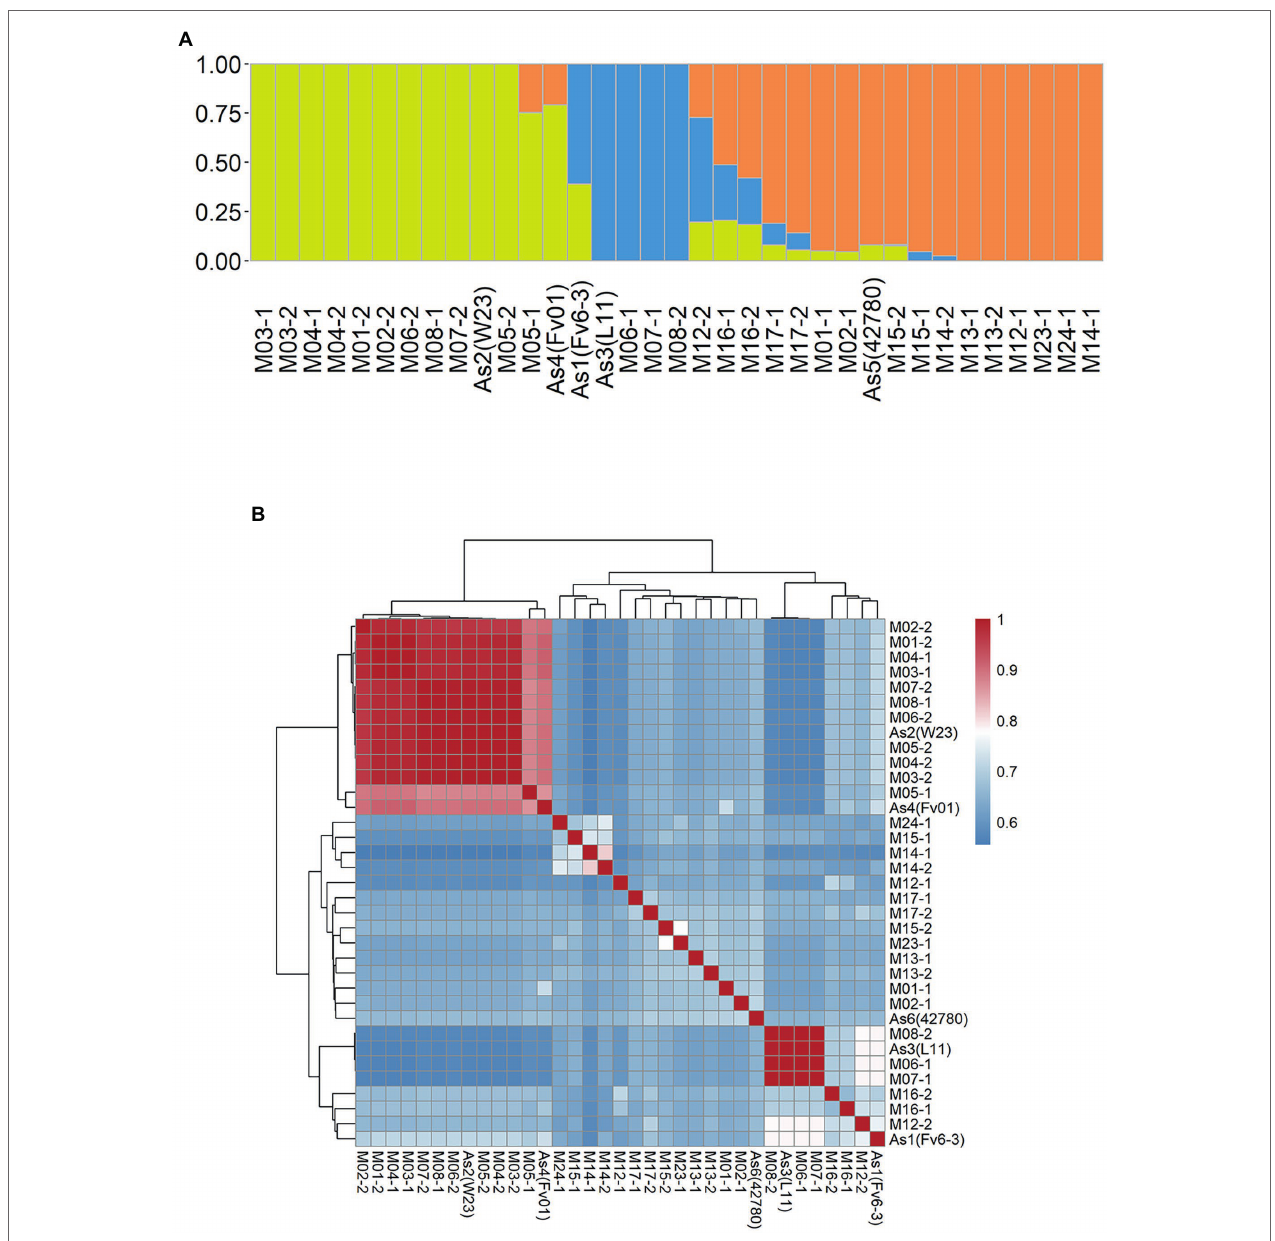
FIGURE 4 | Population structure of 35 Flammulina filiformis monokaryons. (A) The 35 strains contained 3 ancestral genetic components and their proportions, and different colors represented different ancestral genetic components. (B) Identity-by-Stat (IBS) was used to analyze the genetic relationship of 35 F. filiform is